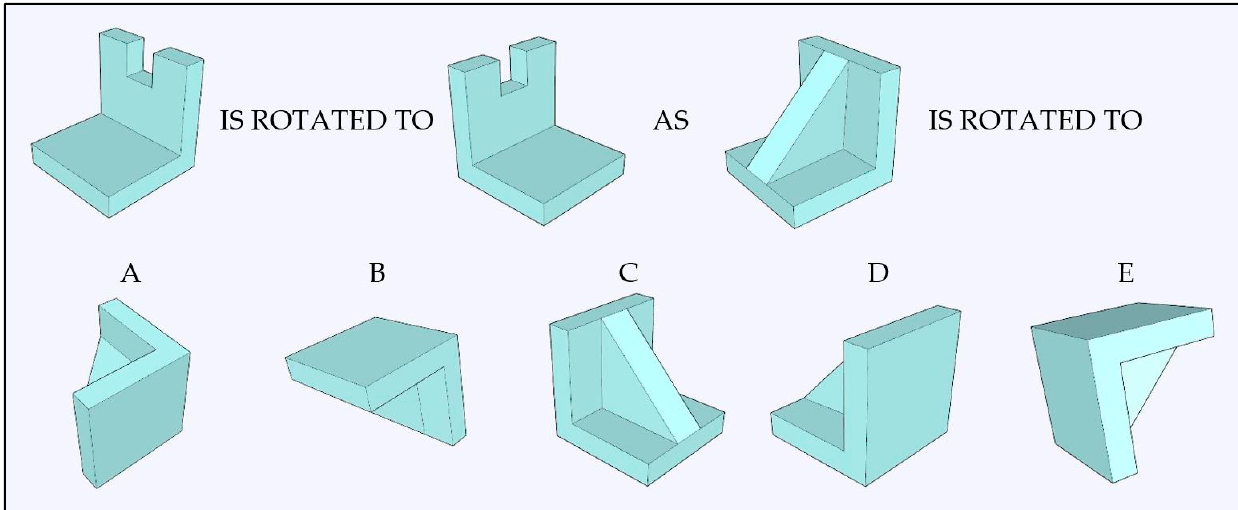
Figure 5. PSVT: R sample question.